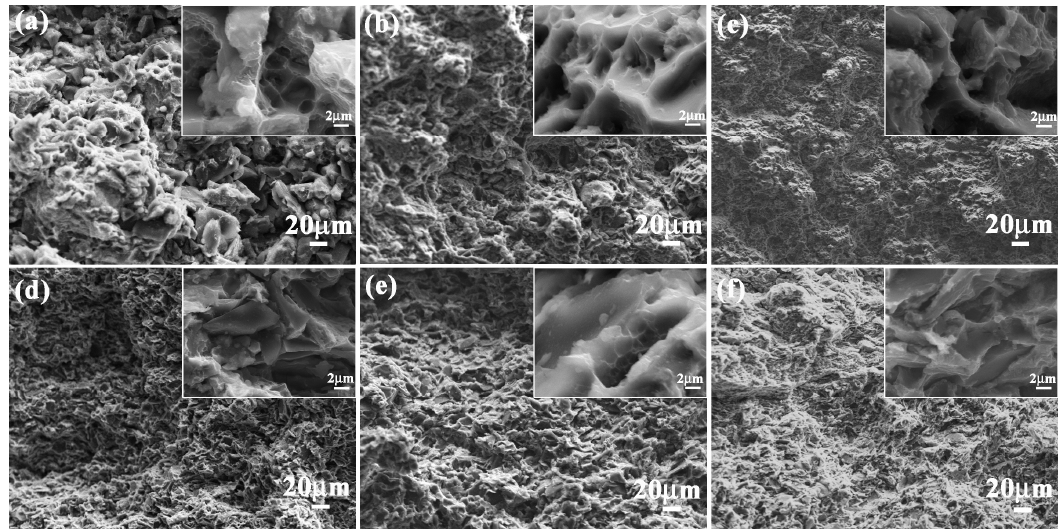
Figure 10. Impact appearance of ( a ) Outer layer; ( b ) Middle layer; and ( c ) Inner layer of bionic Meretrix lusoria shell composite material and ( d ) Outer layer; ( e ) Middle layer; and ( f ) Inner layer of bionic Rapana venosa shell composite material.